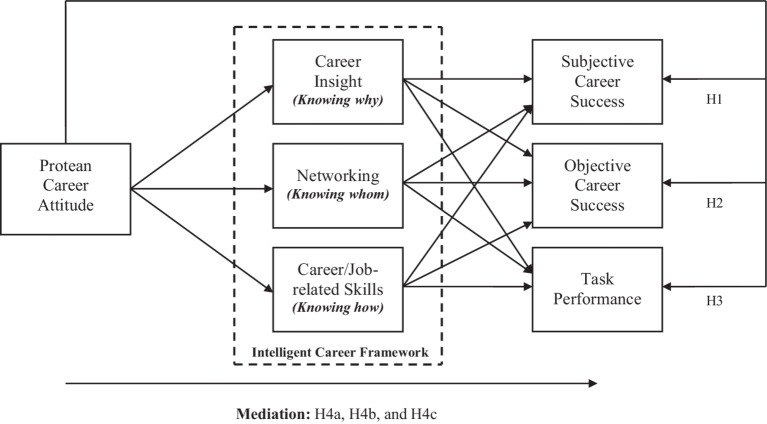
The research model.